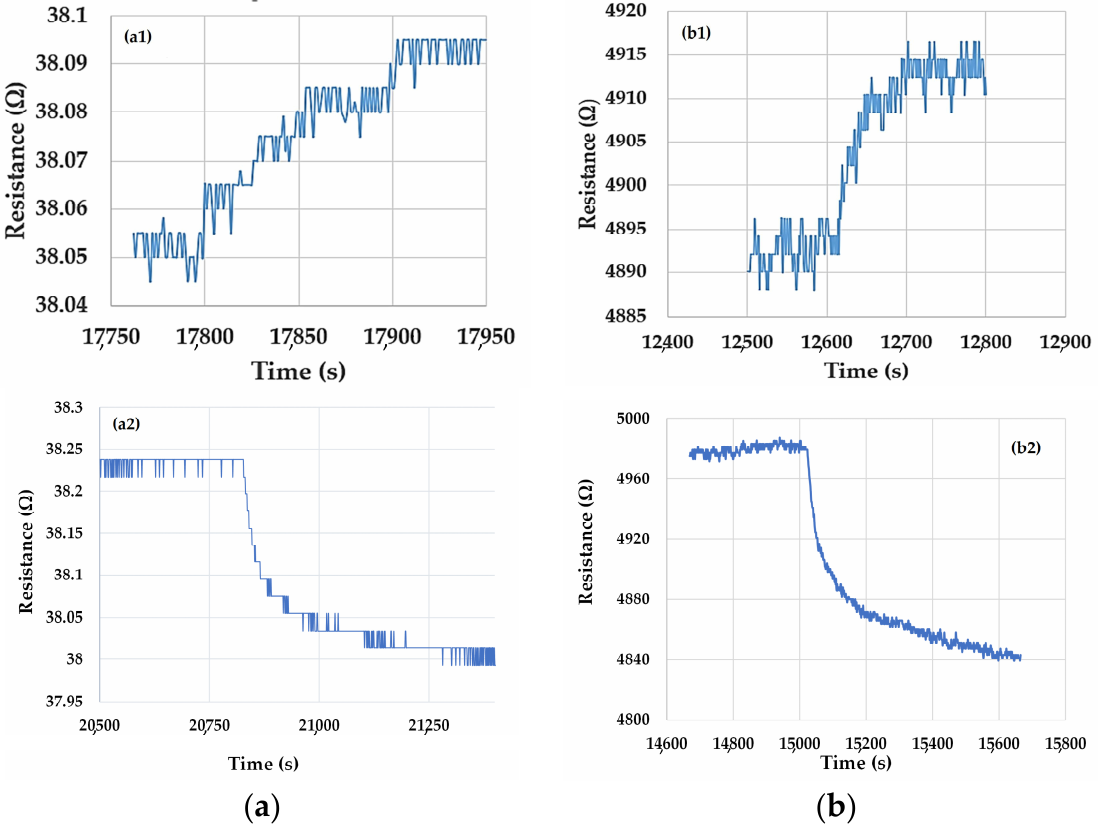
Figure 6. Response and recovery times of the chemiresistive ethanol sensors with sensing films kept at room temperature and consisting of ( a ) ox-SWCNH / ZnO / PVP = 5 / 2 / 1 (mass ratio); ( a1 ) response time, and ( a2 ) recovery time, and ( b ) ox-SWCNH / ZnO / PVP = 5 / 3 / 2 (mass ratio); ( b1 ) response time, and ( b2 ) recovery time. Response time was measured for a change in ethanol vapor concentration from 2 to 5 mg / L, while the recovery time was measured for a change in ethanol vapor concentration from 25 mg / L to 0 mg / L. For both cases, the flow rate of air passing through liquid ethanol was varied, while the total flow rate was kept constant at 1 L /